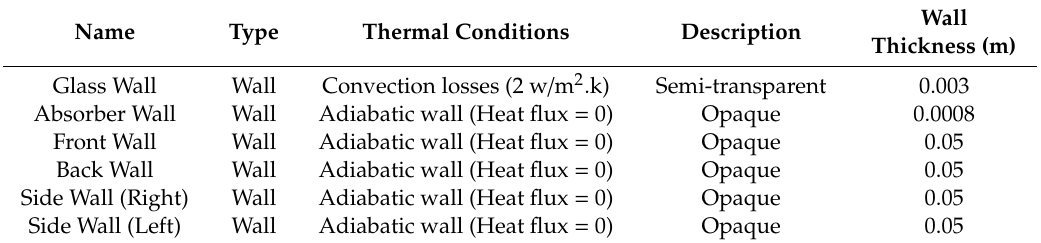
Table 2. Boundary conditions and boundary types.